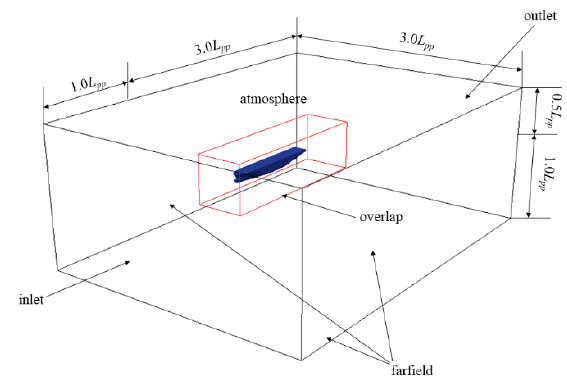
Figure 2. Computational domain and boundary condition.